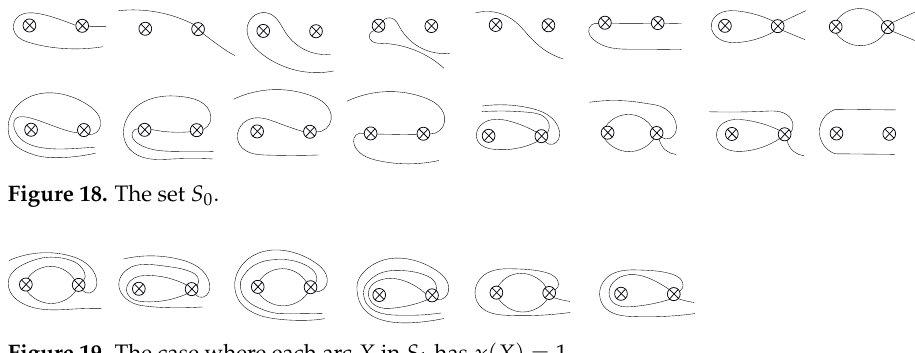
Figure 19. The case where each arc X in S 1 has χ ( X ) =